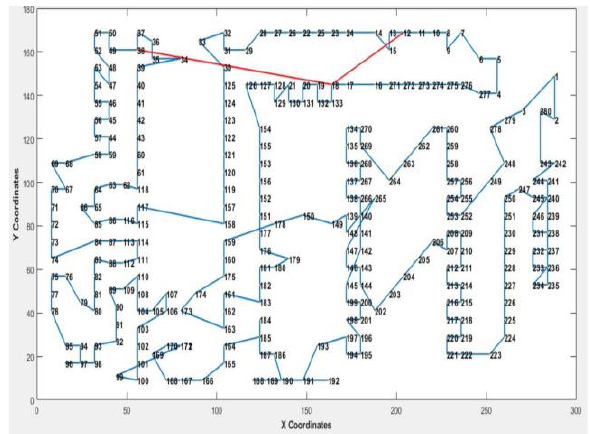
Fig 12. A280 path with constraints cities 12,18 and 38